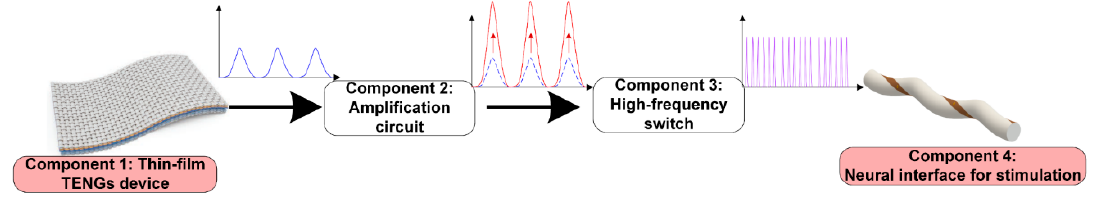
Figure 3. A perspective for the TENG-based self-powered neuroprosthetic system.